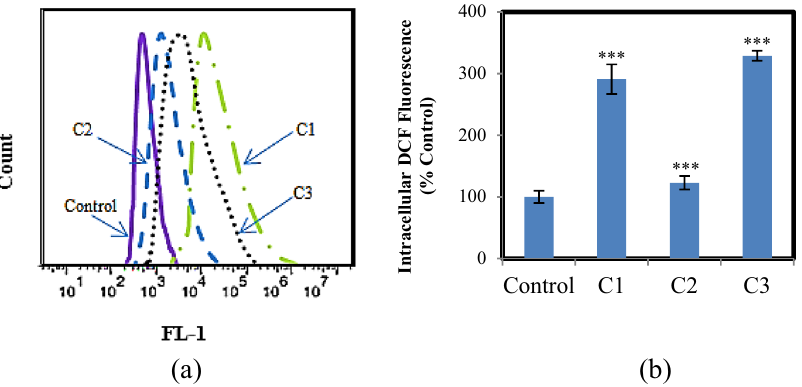
Figure 5. ( a ) Intracellular ROS was detected in A375 cells after treatment with vehicle control and complexes for 24 h; ( b ) Quantification of the flow cytometric results in ( a ) showing the percentage of cells with increased intracellular DCF oxidation compared to control cells. Results are the mean ± S.E.M (n = 3) * p < 0.05, ** p < 0.01, *** p <